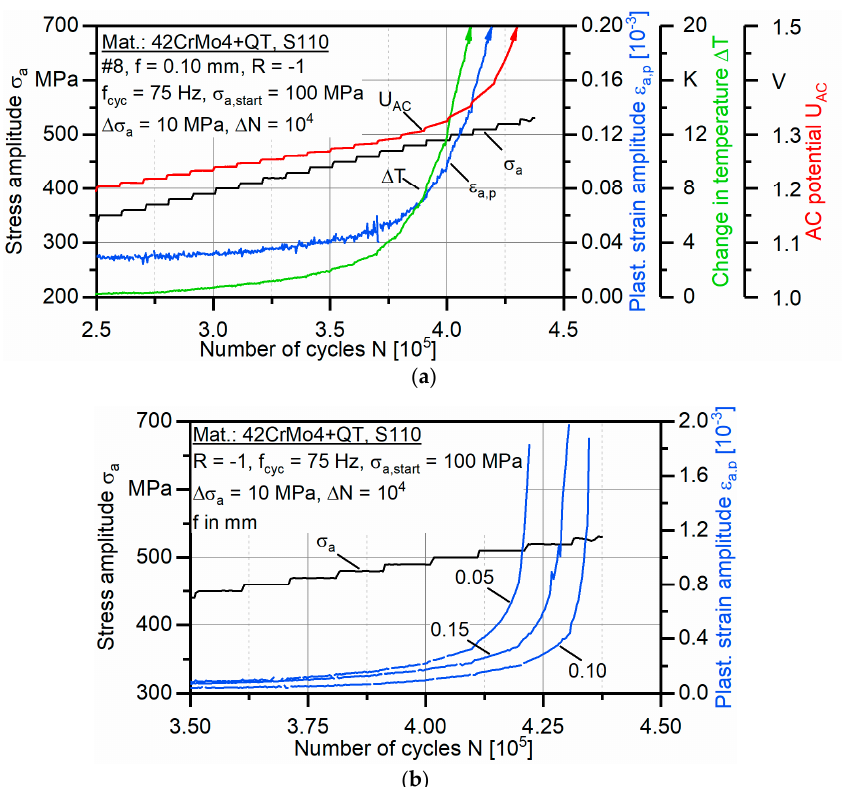
Table 3. Results of load increase tests on 42CrMo4 + QT.